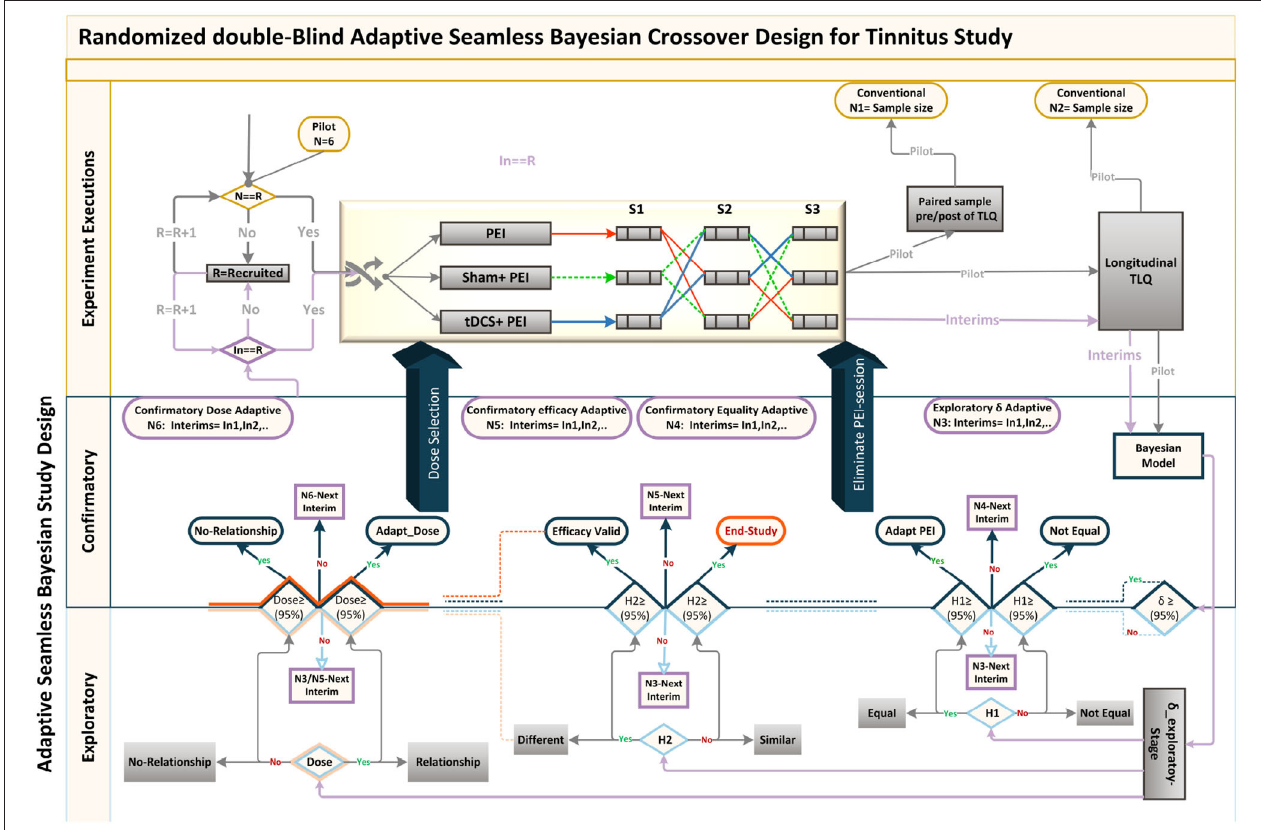
FIGURE 6 | Adaptive Seamless Bayesian Study Design: Experiment execution: Study recruitment, randomization, interim applications, three crossover interventions were illustrated. Interventions were PEI, “tDCS + PEI,” and “Sham + PEI.” Six patients were recruited and randomly assigned to the interventions based on the William-design. Conventionally, either (paired sample analysis)TLQ difference between before and after interventions or (longitudinal analysis) repeated measures of surrogate endpoint TLQat specific time-points could be used for sample size calculation. Frequent interim analyses based on Markov-chain Monte Carlo estimate Bayesian posterior probability distributions, with multiple imputation and estimation of unknown trial parameters and patient outcomes. Exploratory and confirmatory stages: The seamless design connects independent trials inside a single study. An Adaptive-Seamless Bayesian (ASB) design consolidates with two stages exploratory-stage and confirmatory-stage. The Minimum Clinical Efficacy ( δ ) is defined as 50% of the observed effectiveness for PEI treatment, which was determined after assessing the variability observed during the online period. Since PEI has not yet been practiced for the tinnitus population, the Bayesian model utilized the probabilistic model to represent all uncertainties within the model ( Gelman et al., 2013), both the hypotheses and prior knowledge (Processed- δ or non-credible δ ). Testing hypotheses are H 1 : The conscious pairing of PEI simultaneously with tinnitus perception results in the correction of loudness misperception. In the current ASB the following hypotheses were tested simultaneously, H 2 : Active HD-tDCS on the left-DLPFC but not sham facilitates correction of the loudness misperception, and Dose : A dose-response relationship between HD-tDCS dosage and correction of loudness misperception exists. Since the processed- δ is not changed, interim analyses on hypotheses in exploratory and confirmatory stages will be processed. The results of the hypotheses are partially valid within the uncertainty range of the processed- δ . When δ becoming valid decision making and adaptation on H 1 and H 2 is possible. However, as soon as Processed- δ is changed, the hypotheses needed to be reevaluated. When δ and H 2 became credible concurrently, regulating the dose and judgment about the dose-response relationship is possible. In other cases, the validity of dose-related parameters depends on processed- δ and efficacy